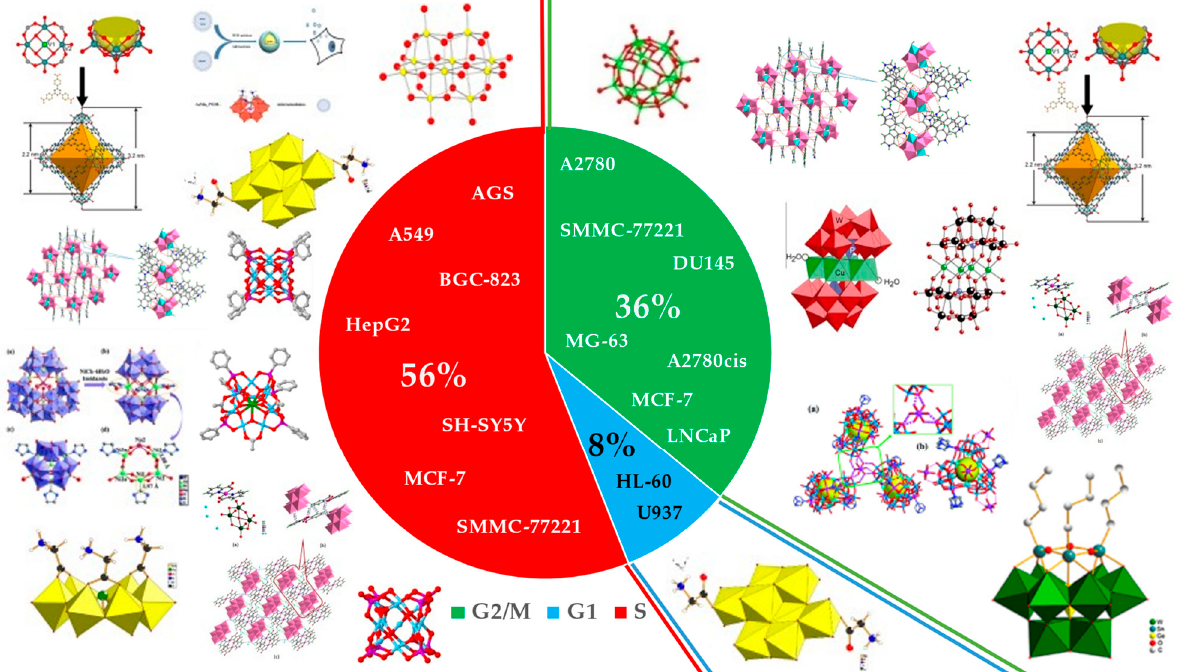
Figure 5. Percentage of the number of articles in which each cell cycle arrest occurred, referring to each POM used and respective cell lines. Color code: red—S phase [57,59,61–65,67]; green—G2/M [33,58,59,63,64,66,68] phase; and blue—G1 phase [60]. Reproduced from Ref. [63] and [66] with permission from the Royal Society of Chemistry. Reproduced from Ref. [33,57,60,62] and [72] with permission from Elsevier. Reproduced from Ref. [59] with permission from Wiley. Reproduced from Ref. [61] with permission from Plosone. Reproduced from Ref. [64] with permission from American Chemical Society. Reproduced from Ref. [65] with permission from Springer. Reproduced from Ref. [66] with permission from the Royal Society of Chemistry.